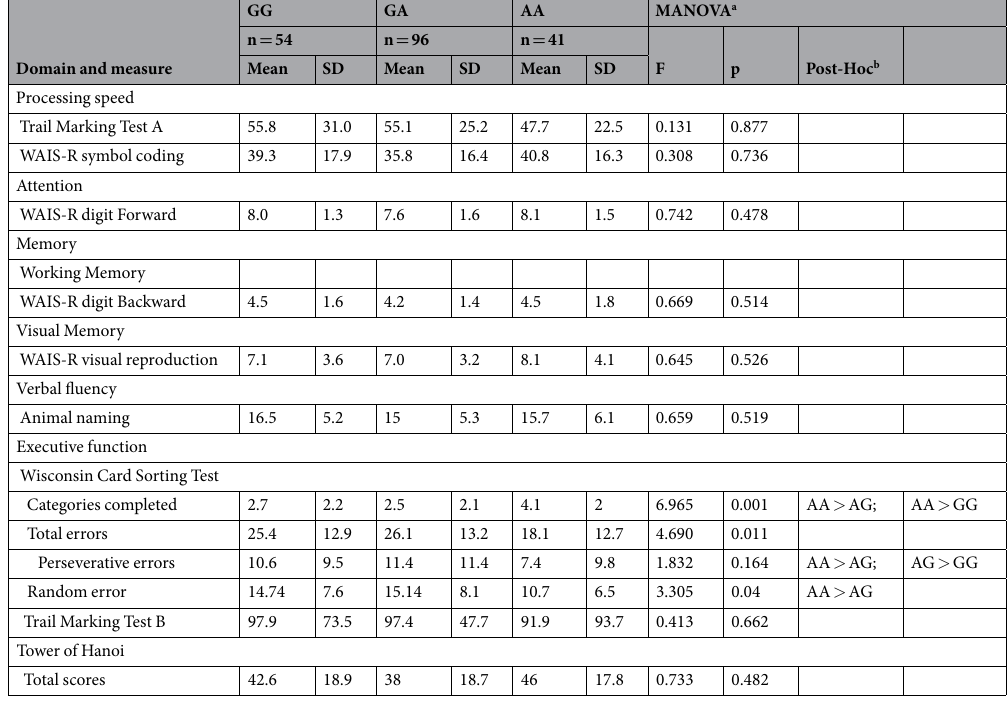
Table 3. Performance on neuropsychological test by bipolar patients stratified by rs58619945 genotypes. Note: a MANOVA: Multivariate Analysis of Variance; b p < 0.05 with Bonferroni